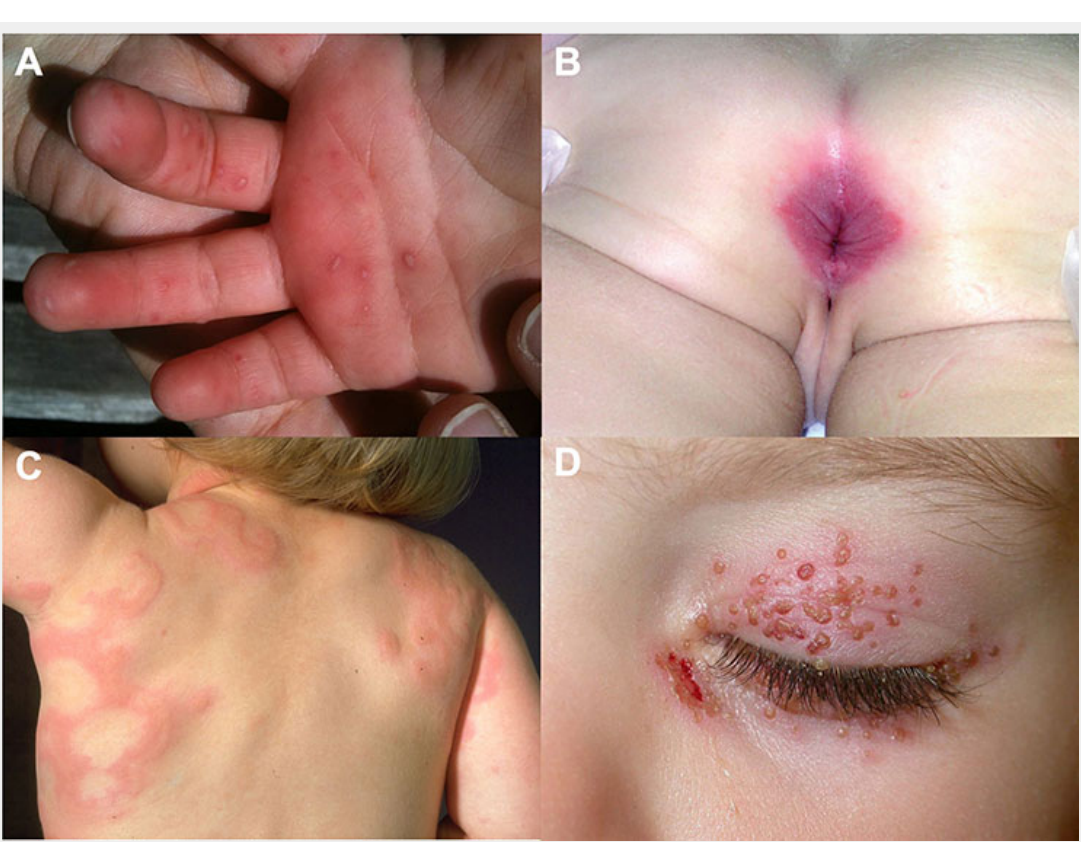
Clinical examples of skin disorders which were commonly encountered in the Pediatric Emergency Department. 1A. Hand-foot-mouth disease. 1B. Perianal streptococcal infection. 1C. Anular urticaria of childhood. 1D. Periocular herpes simplex virus